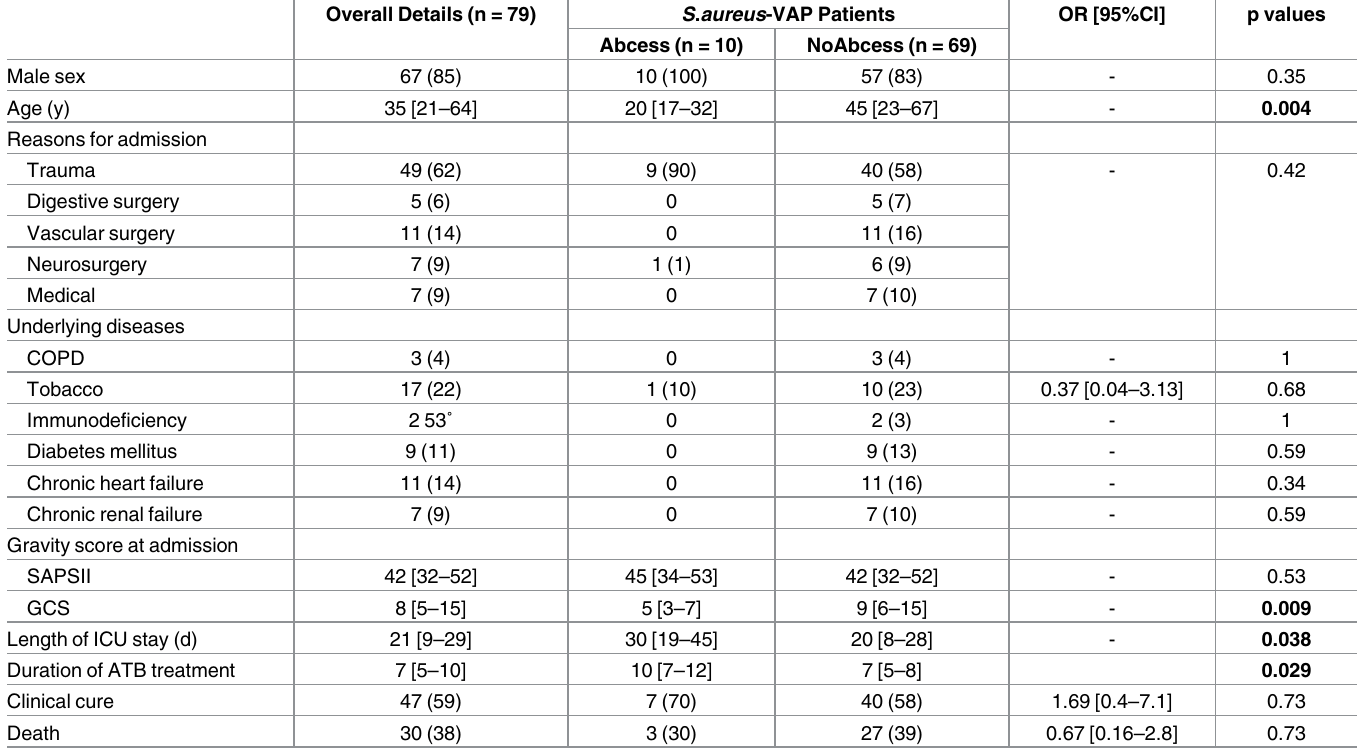
Table 1. Overall details of the patients and differential characteristics of those that suffered